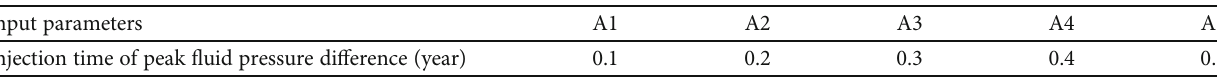
Table 3: Input parameters of scenario A.